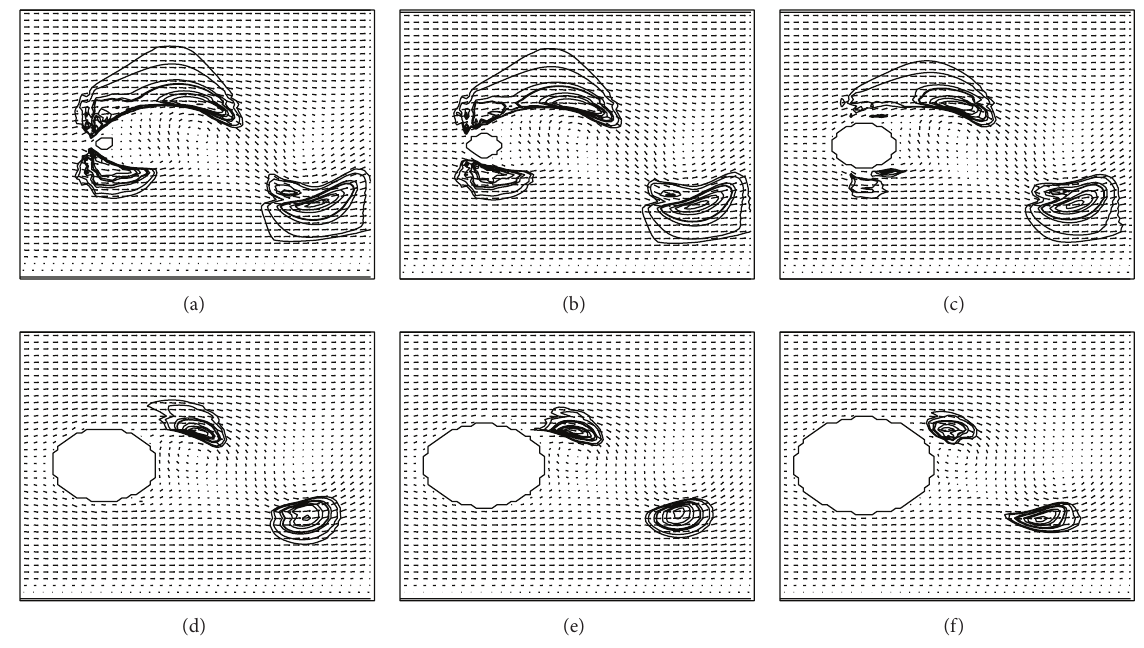
Figure 14: Velocity field on the 𝑈 , 𝑉 plane obtained at different depths; cross-section (a) shows the velocity field on the surface, cross-section (b) at 0.011m, cross-section (c) at 0.023m, cross-section (d) at 0.046 m, cross-section (e) at 0.58 cm, and (f) at the bottom.